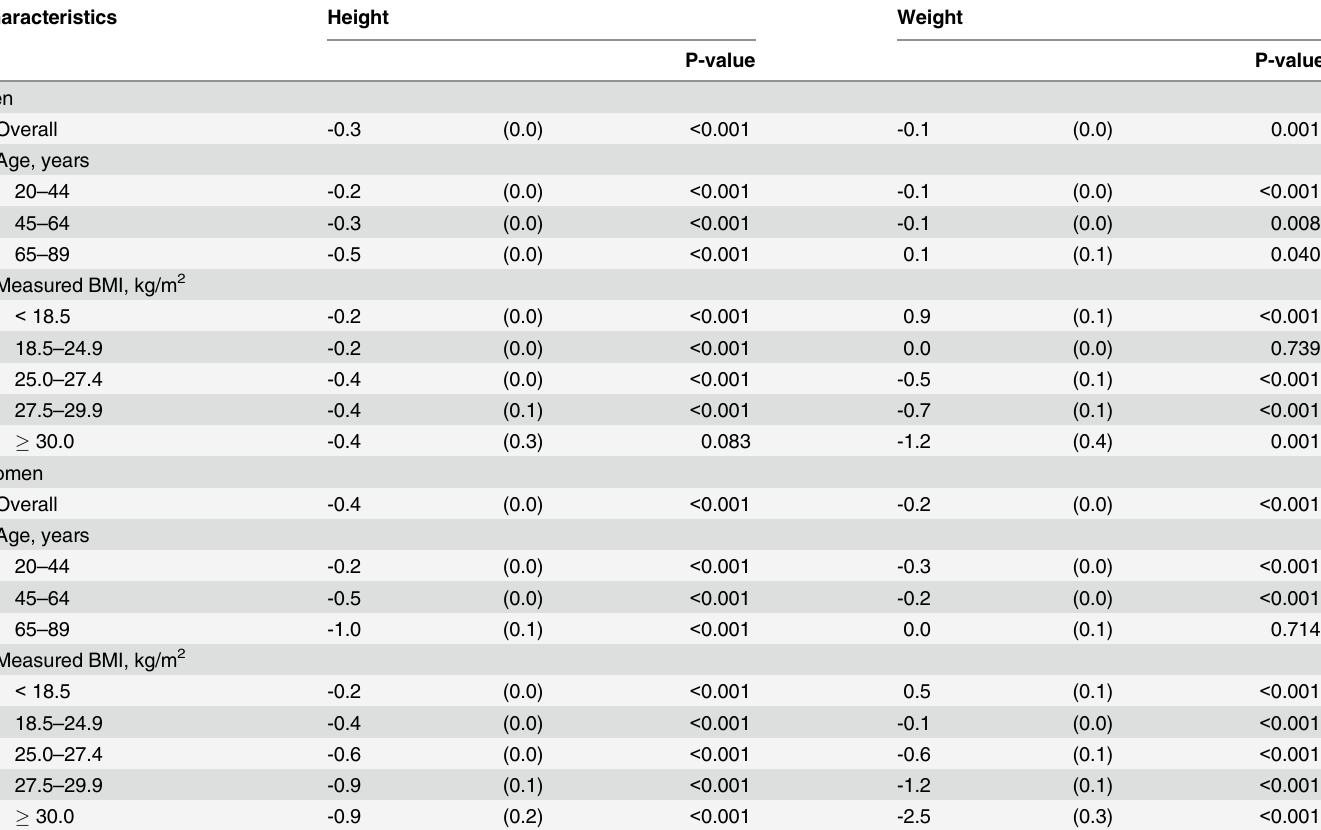
Table 4. Contributions of differences in mean height and weight to differences in mean body mass index (kg/m 2 ) based on the National Nutrition Survey, 1986.